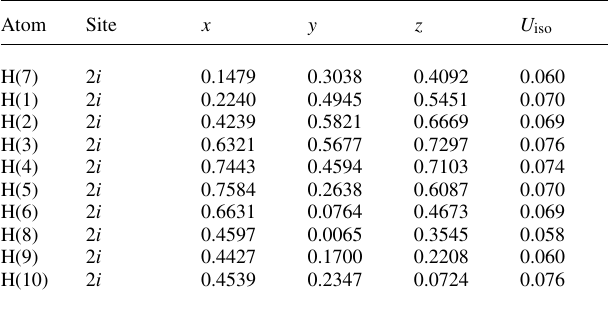
Table 2. Atomic coordinates and displacement parameters (in Å 2 )